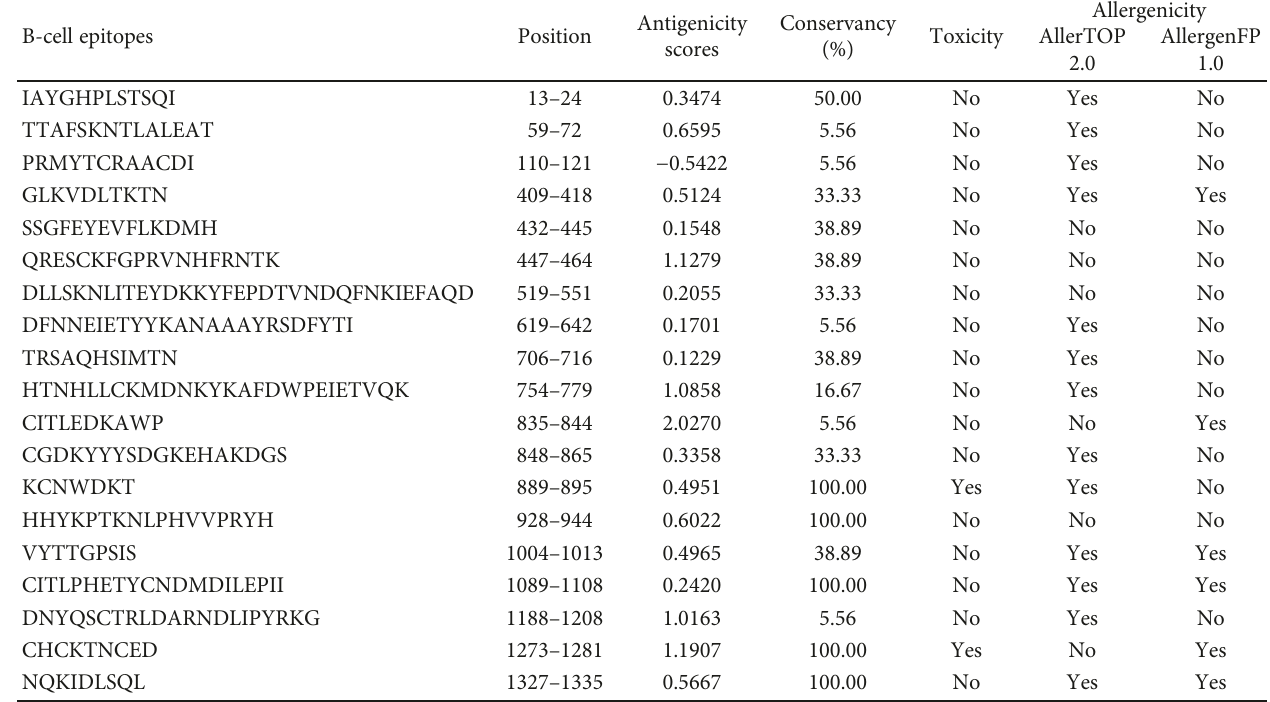
Table 4: Linear B-cell epitopes of the polyprotein of OROV predicted by LBtope. B-cell epitopes